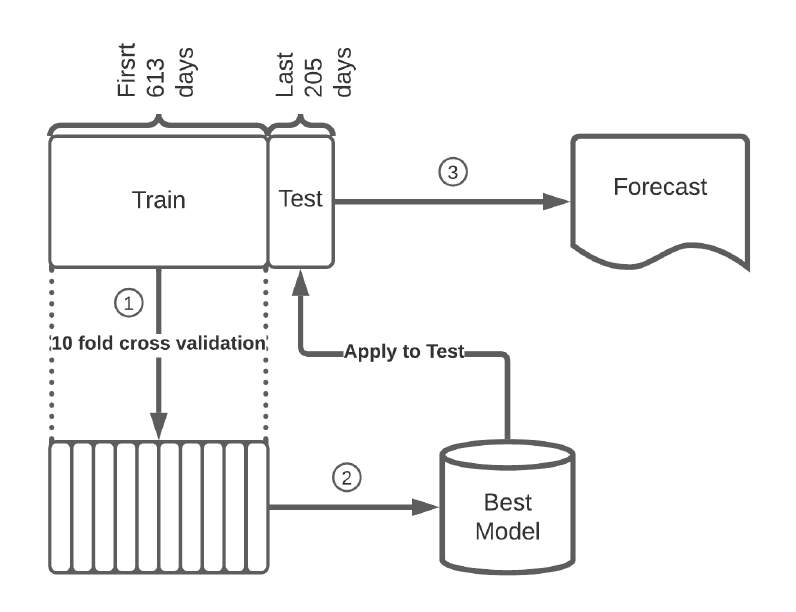
Figure 2. Diagram of Random Forest empirical model development. Firstly, the training set is used to find the best Random Forest model, applying a cross-validation technique to ensure the optimal maximum depth of trees. Finally, the performance of the forecast is checked using the testing